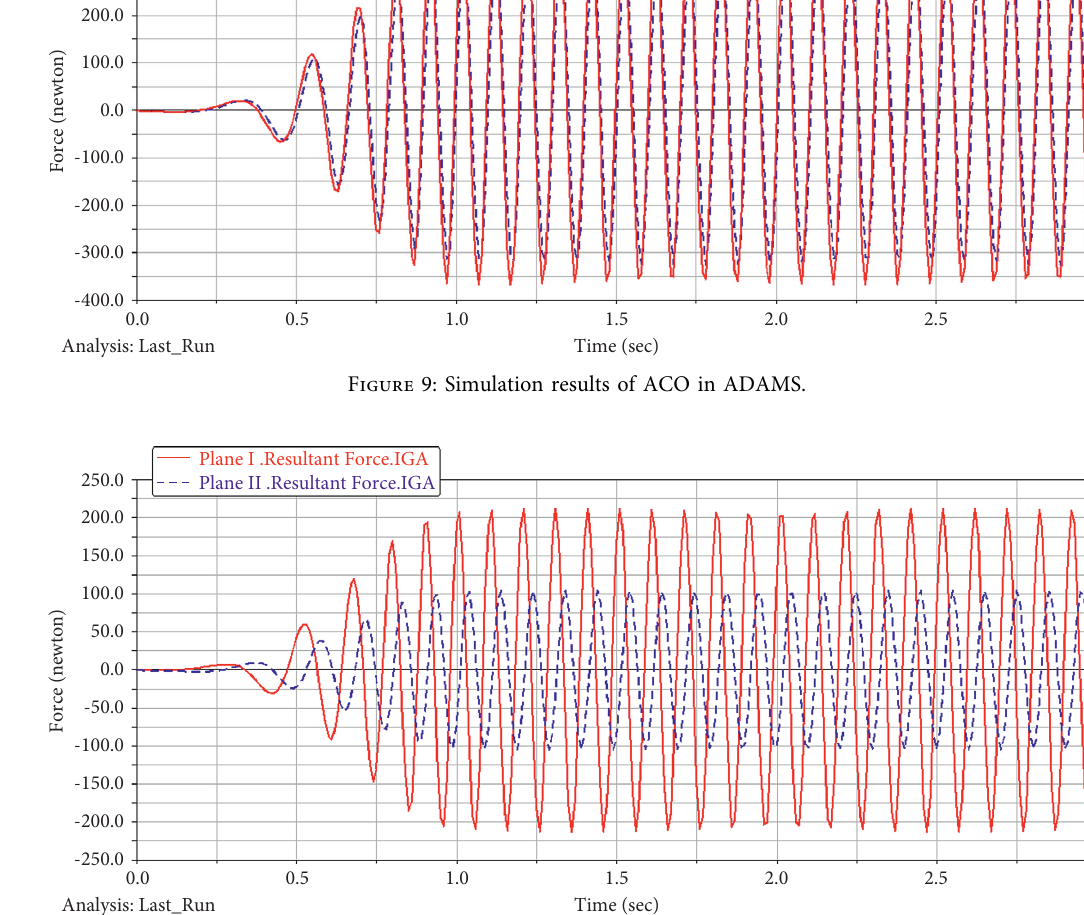
Figure 10: Simulation results of IGA in ADAMS.